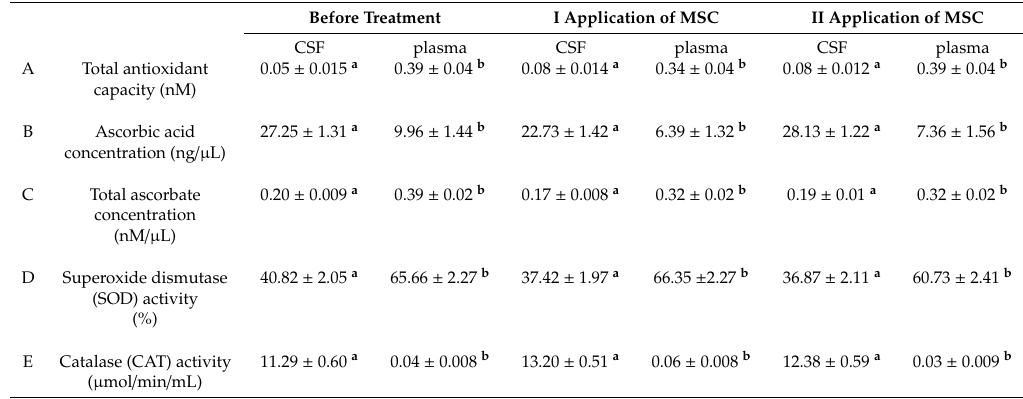
Figure 5. Catalase activity in CSF (a) and plasma (b) of the patients in MCS before (white bars) and after first (grey bars) and second (black bars) transplantation of BM-MSC. The statistical analysis was determined by a one-way ANOVA followed by Tukey’s multiple comparison test ( p < 0.05). Asterisks indicate di ff erences in the antioxidant capacity between examining groups (* p < 0.05; ** p < 0.001). Table 2. Total antioxidant capacity (A), ascorbic concentration (B), total ascorbate concentration (C), super oxide dismutase (D), and catalase (E) activity in CSF and plasma in patients in MCS before and after BM-MSC therapy. Small letters a and b indicate statistical di ff erences in the measured parameters between CSF and plasma within the control, first, and second transplantation of BM-MSC. The statistical analysis was determined by Student’s t-test ( p < 0.0001). Before